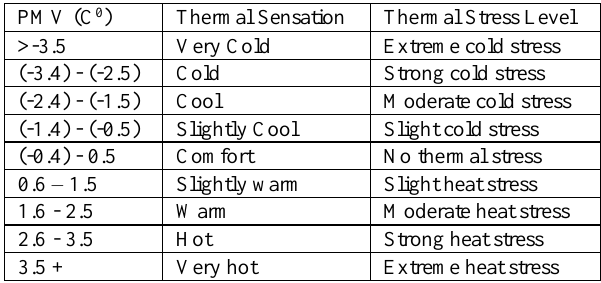
Table 1. PMV Index Thermal Stress Levels (Matzarakis et al. 1999, p.77)